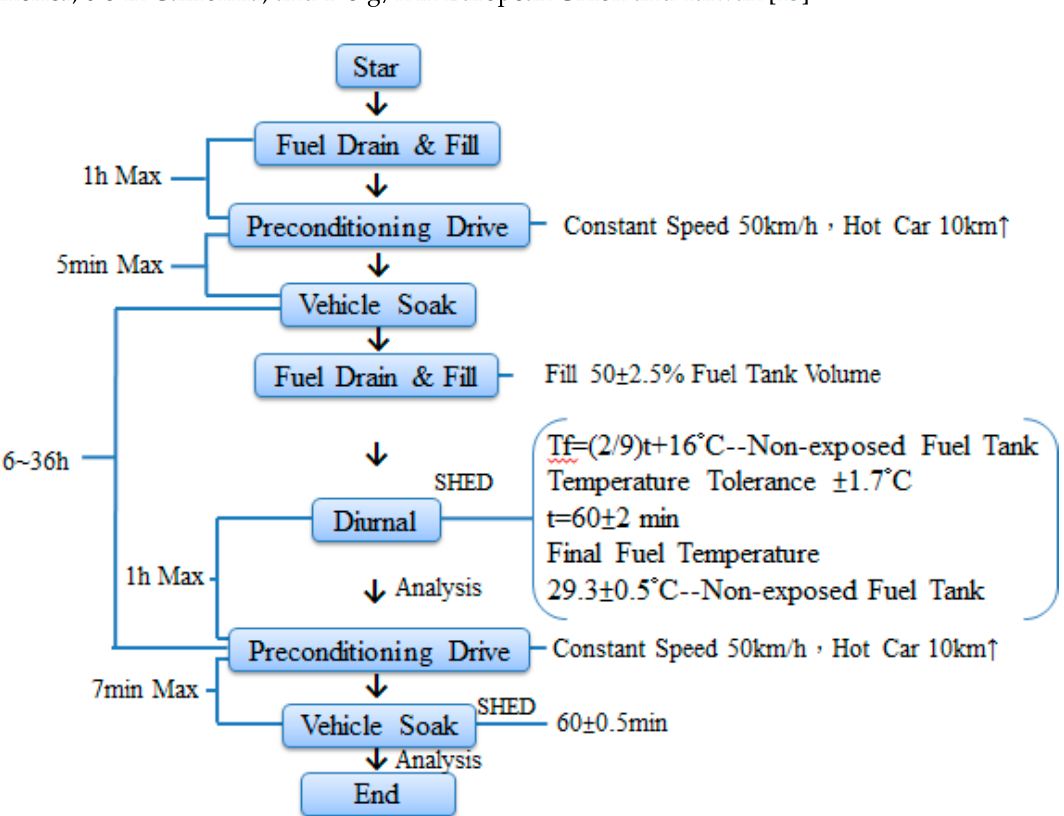
Figure 5. Exploded view of the self-made carbon canister.